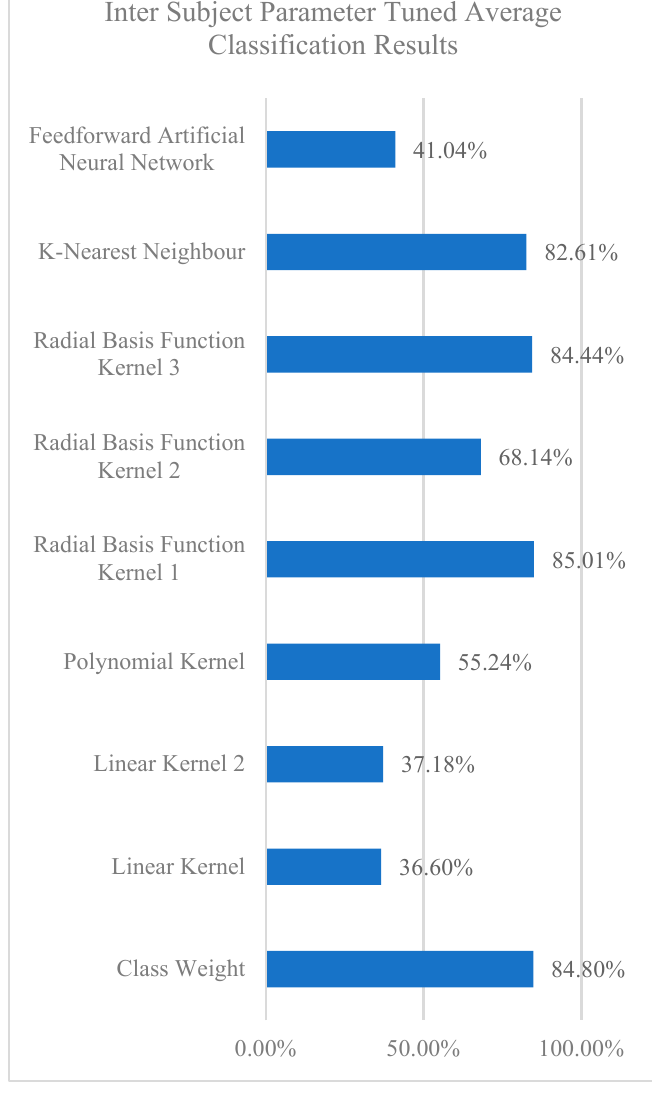
Figure 7. Parameter-tuned SVM and FANN classification results.